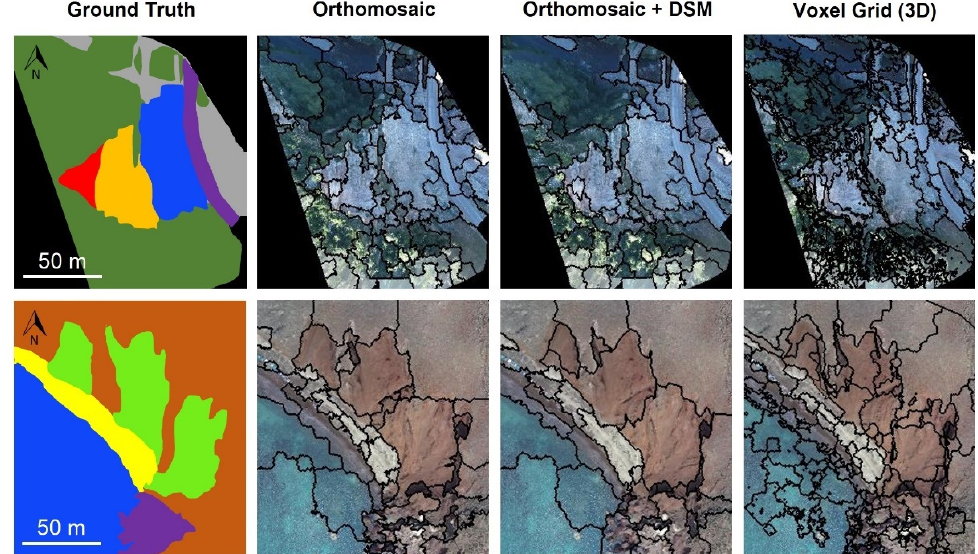
Figure 8. Examples of superpixel/supervoxel-based normalized cut segmentation outputs. From left to right: the ground truth annotation, 2D, 2.5D, and 3D input model. In the Proussos case, above, elements such as the scarp (red), depletion zone (yellow), accumulation zone (blue), road (purple), and non-affected area (green) are delineated, while in the Red Beach case, below, the annotated elements include landslide areas (green), rockfall deposits (purple), the beach (yellow), waterbody (blue), and the non-affected area